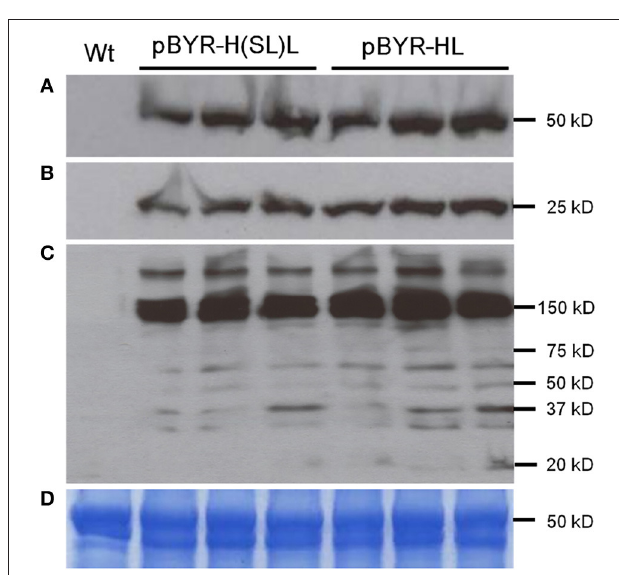
FIGURE 6 | Western blot analysis of plant-derived 6D8. Protein samples were separated on a 4-20% SDS-PAGE gradient gel under denaturing and reducing condition (A,B) or under non-reducing condition (C) and blotted onto a PVDF membrane. The membrane was incubated with a goat anti-human gamma chain antibody or goat anti-human kappa chain antibody to detect heavy chain (A) or light chain (B,C) . Wt: Protein samples extracted from uninfiltrated leaves; lanes marked pBYR-H(SL)L, protein samples extracted from the leaves infiltrated with dual replicon construct pBYR-H(SL)L; lanes marked pBYR-HL, protein extracted from the single replicon construct pBYR-HL. (D) Commassie blue stained gel is shown for normalized total protein loading.